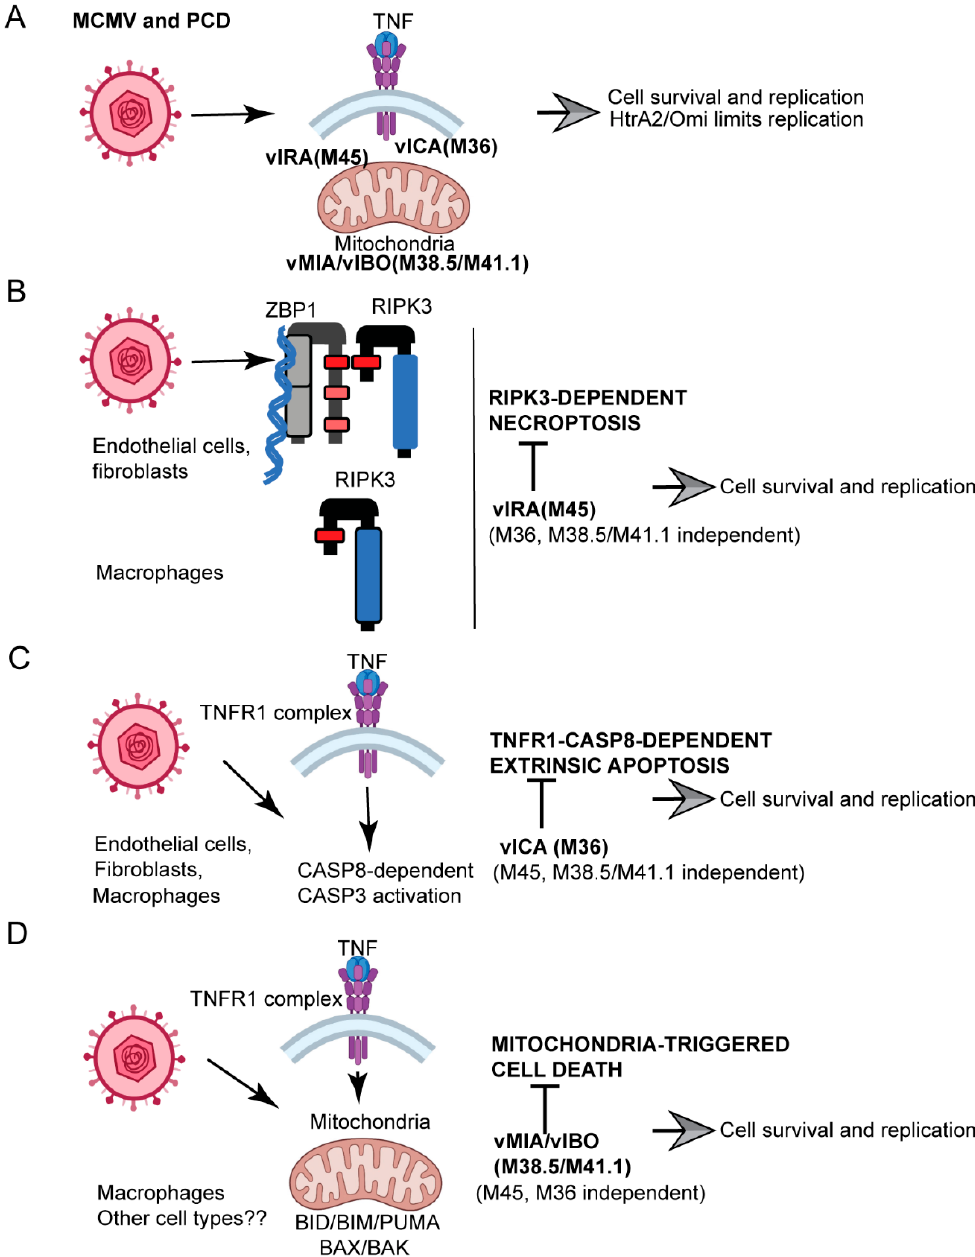
Figure 5. Schematic summary of how PCD pathways interface with MCMV infection. ( A ) HtrA2/Omi regulates MCMV replication in macrophages. ( B ) vIRA (M45) suppresses RIPK3-dependent necroptosis via ZBP1-dependent (in nonmyeloid cells) and ZBP1-independent (in macrophages) pathways. ( C ) vICA (M36) suppresses TNFR1-dependent activation of CASP8 in myeloid and non-myeloid cells. ( D ) vMIA/vIBO (M38.5/M41.1) suppresses BID/BIM/PUMA-mediated BAX/BAK-dependent mitochondrial death signaling. Diagram was generated using BioRender